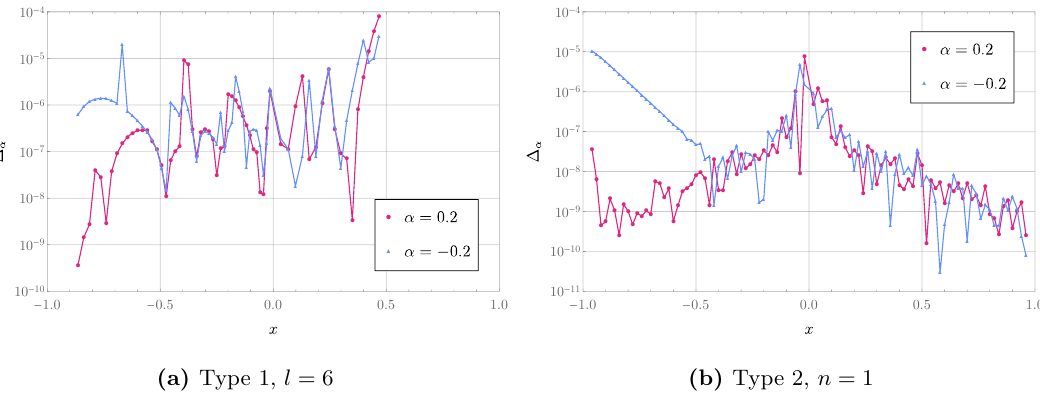
Figure 9 . The relative error ∆ α of the fermion Casimir energy for α = ± 0 . 2 for two representative deformations, computed with a resolution of N = 800 . Figure (a) shows the Type 1 deformation with l = 6 , while figure (b) shows the Type 2 deformation with n = 1